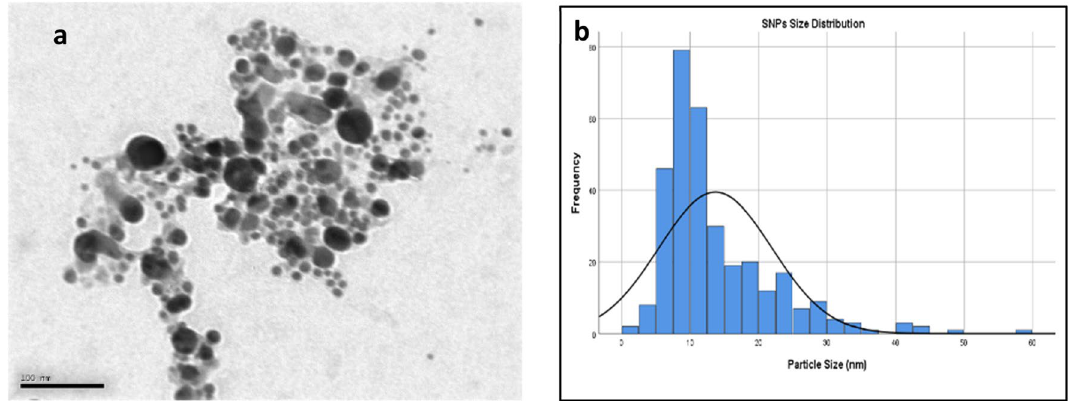
Figure 4. Average size and size distribution of the green synthesized particles detected by TEM image and IMAGEJ